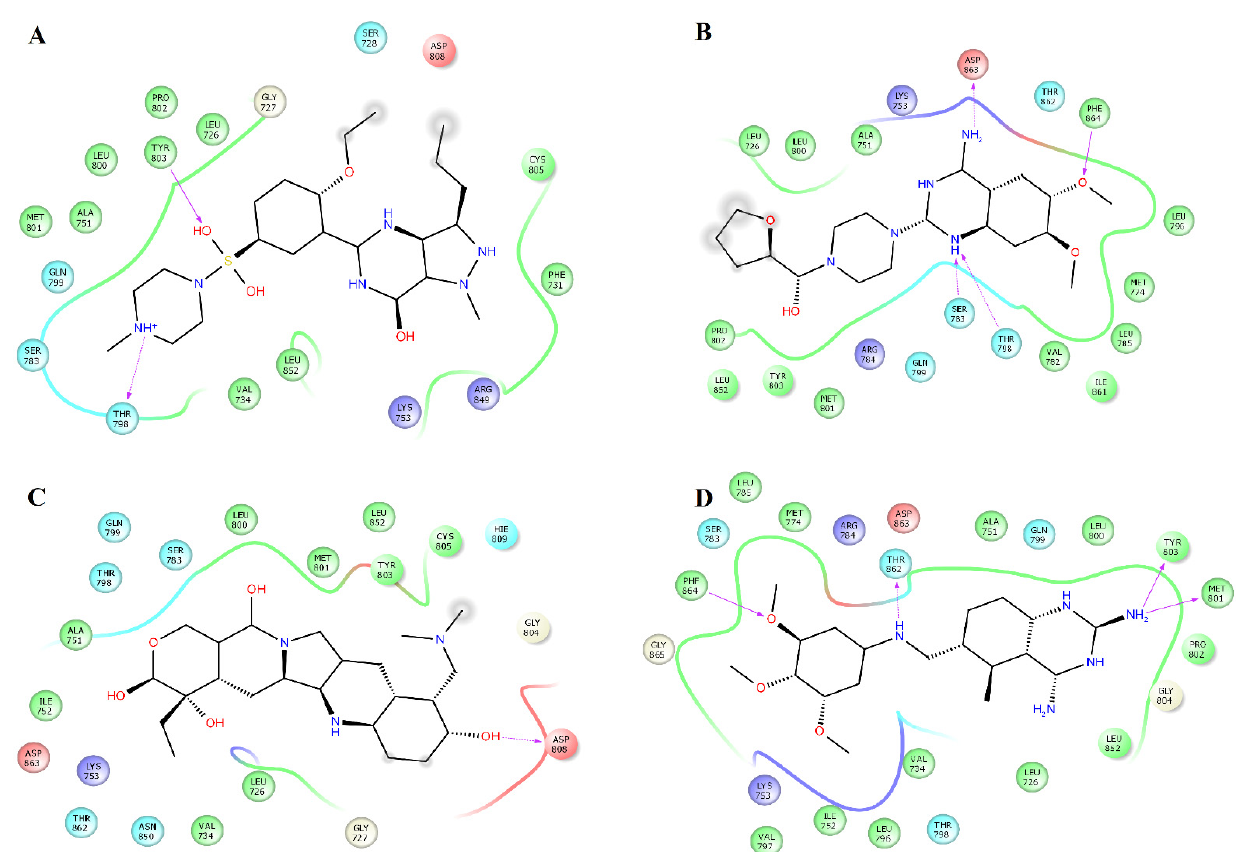
Figure 3. Map of interactions for the complexes between HER2 and sildenafil, terazosin, topotecan, and trimetrexate. Binding conformations for HER2 sildenafil ( A ); HER2 terazosin ( B ); HER2 topotecan ( C ) and HER2 trimetrexate ( D ).